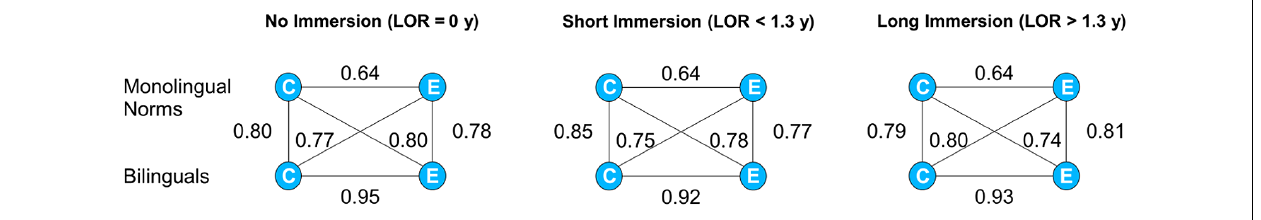
FIGURE 2 | Cross-language correlation matrices for each Immersion group, representing the correlation between lexical categorization patterns in Chinese (C) and English (E) for the bilinguals and native speaker